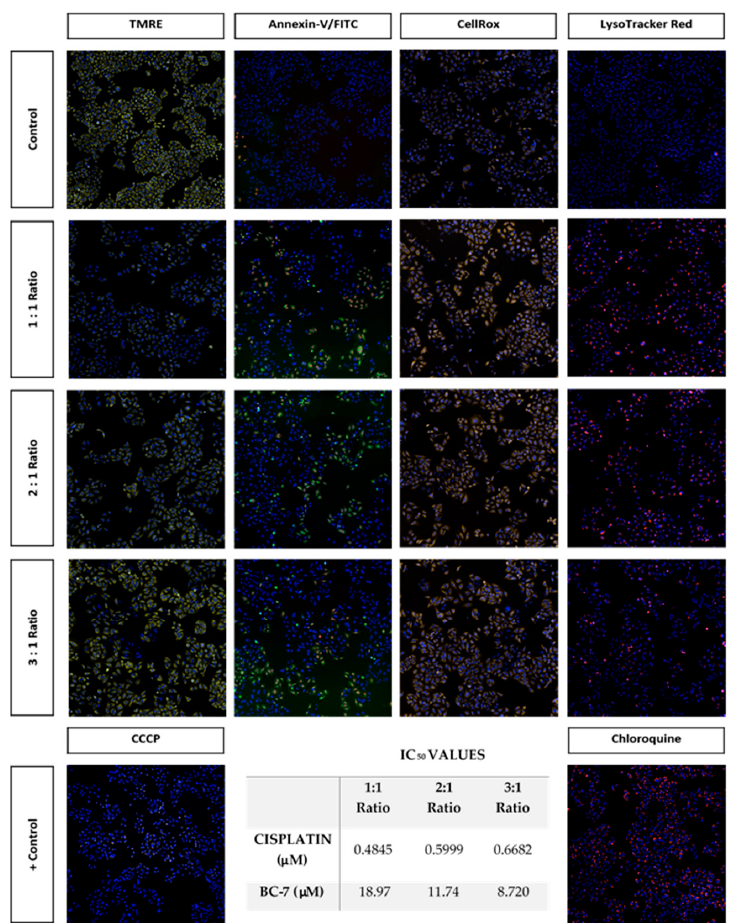
Figure 8. Photomicrographs (10 × magnification) illustrating the e ff ects of synergistic